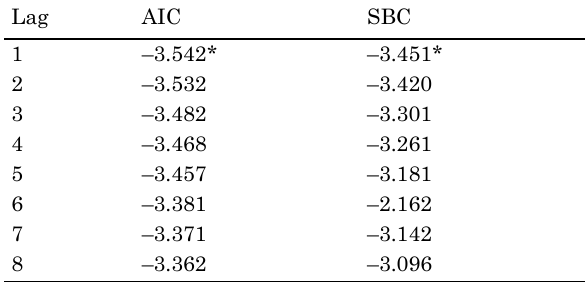
Table 5. Variable section for optimal lag period in VAR model